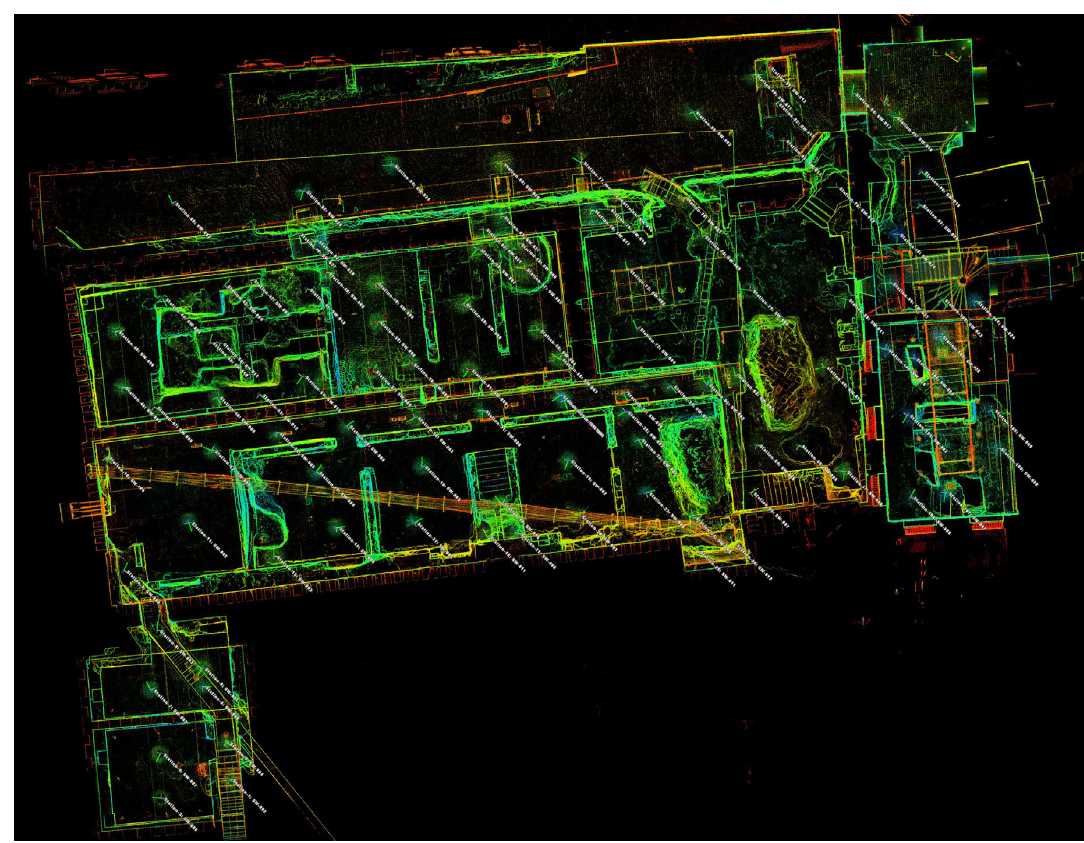
Figure 15. Laser scanning stations horizontal sections.